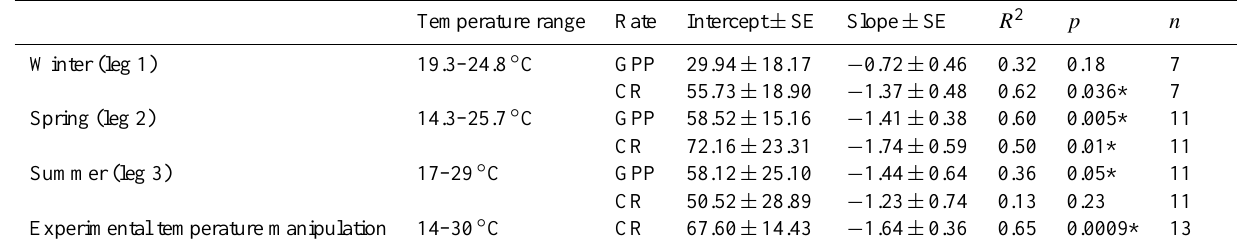
Table 4. Activation energy (eV) as the slope of the regression and the parameters of the Arrhenius relationship between the natural logarithm of chlorophyll a -specific metabolic rates (mmolO 2 mgChl a − 1 d − 1 ) binned by 1 ◦ C and inverted temperature (1 /kT ) for each season and the temperature manipulation experiments in spring.